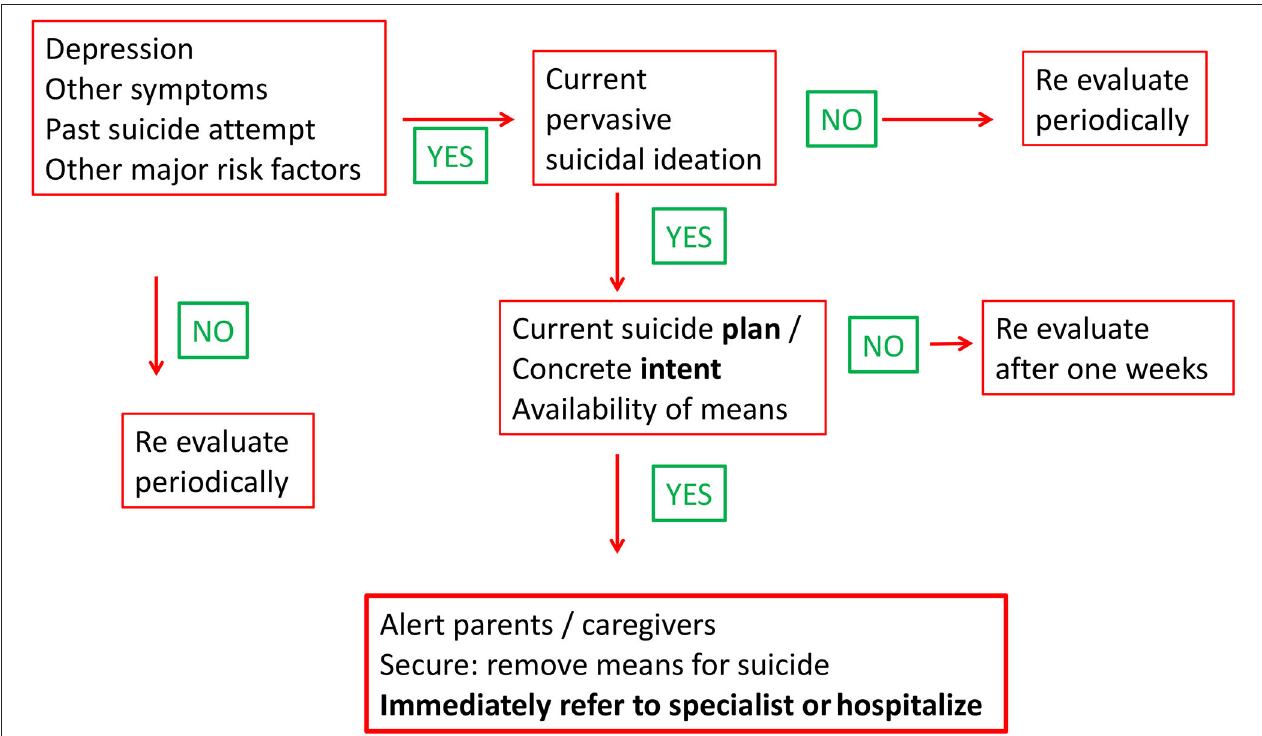
FIGURE 1 | Step by step assessment of suicidal behavior and how to